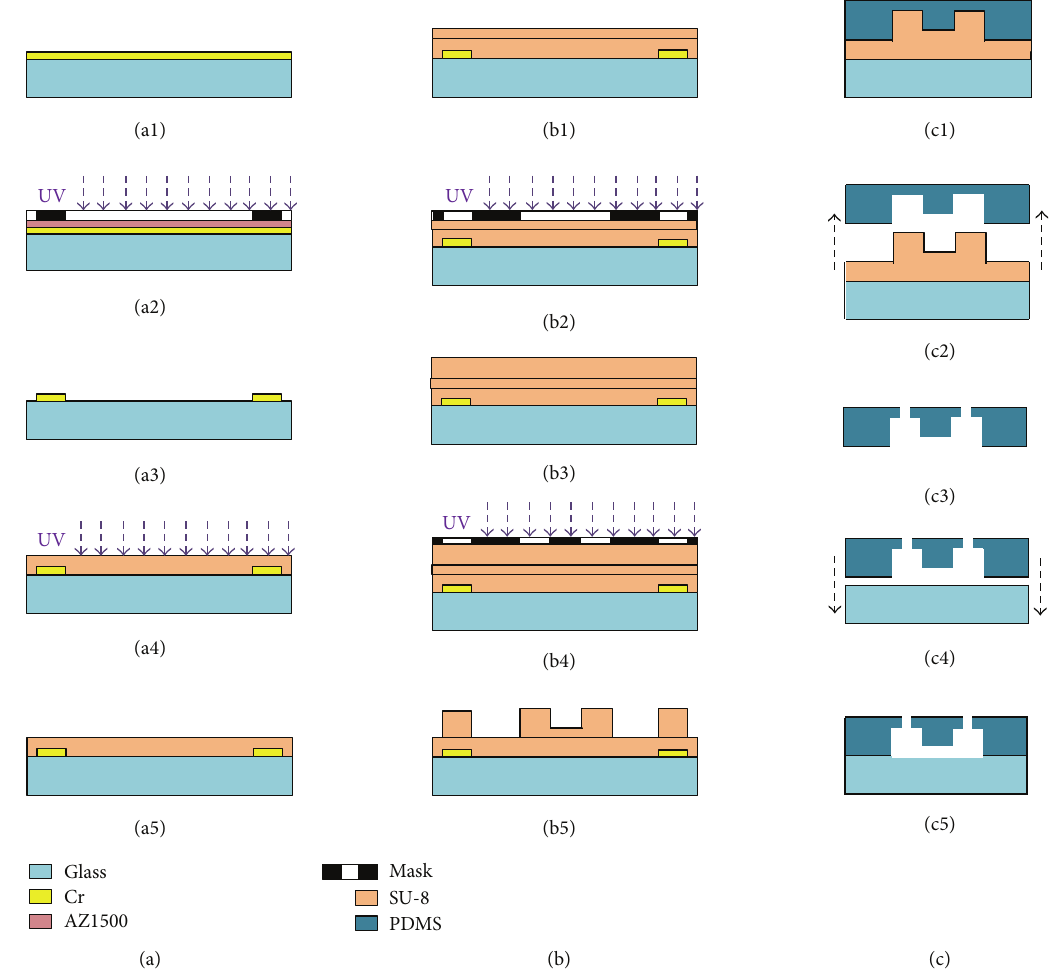
Figure 2: Fabrication process of the microfluidic device including Cr deposition and patterning as alignment marks and SU-8 seed layer fabrication (a), two-layer SU-8 fabrication with alignment (b), and PDMS curing and sealing with glass slides